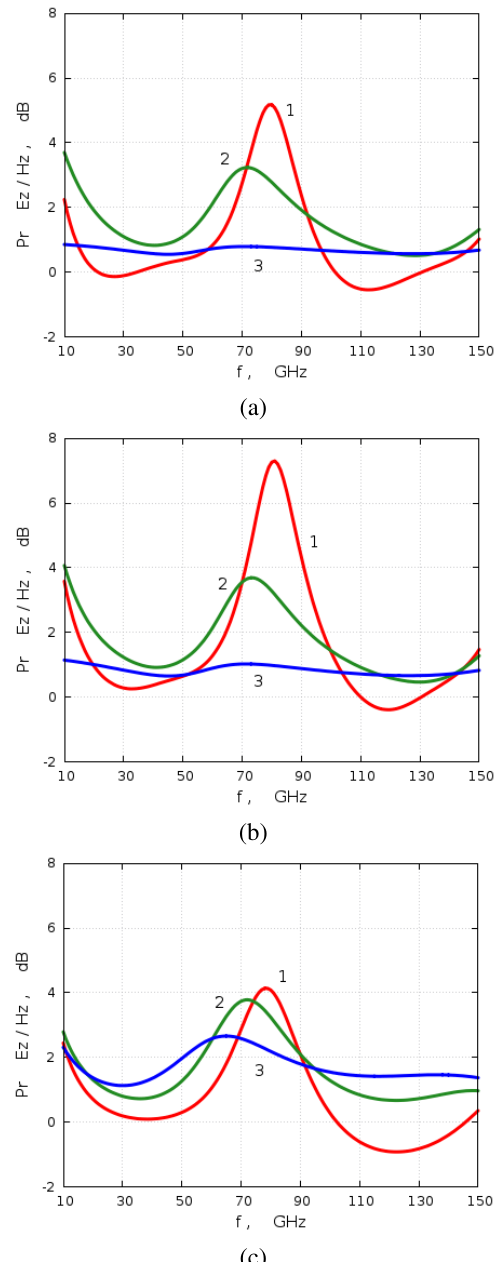
Figure 5: Polarization ratio for transmitted waves through (a) strip-like ( P L = 0 . 1 , 1 , 10 kW/cm 2 ), (b) wire-like ( P L = 1 , 10 , 100 kW/cm 2 ), and (c) fin-like ( P L = 0 . 1 , 0 . 3 , 1 kW/cm 2 ) photo-excited gratings (curves 1 to 3, respectively).